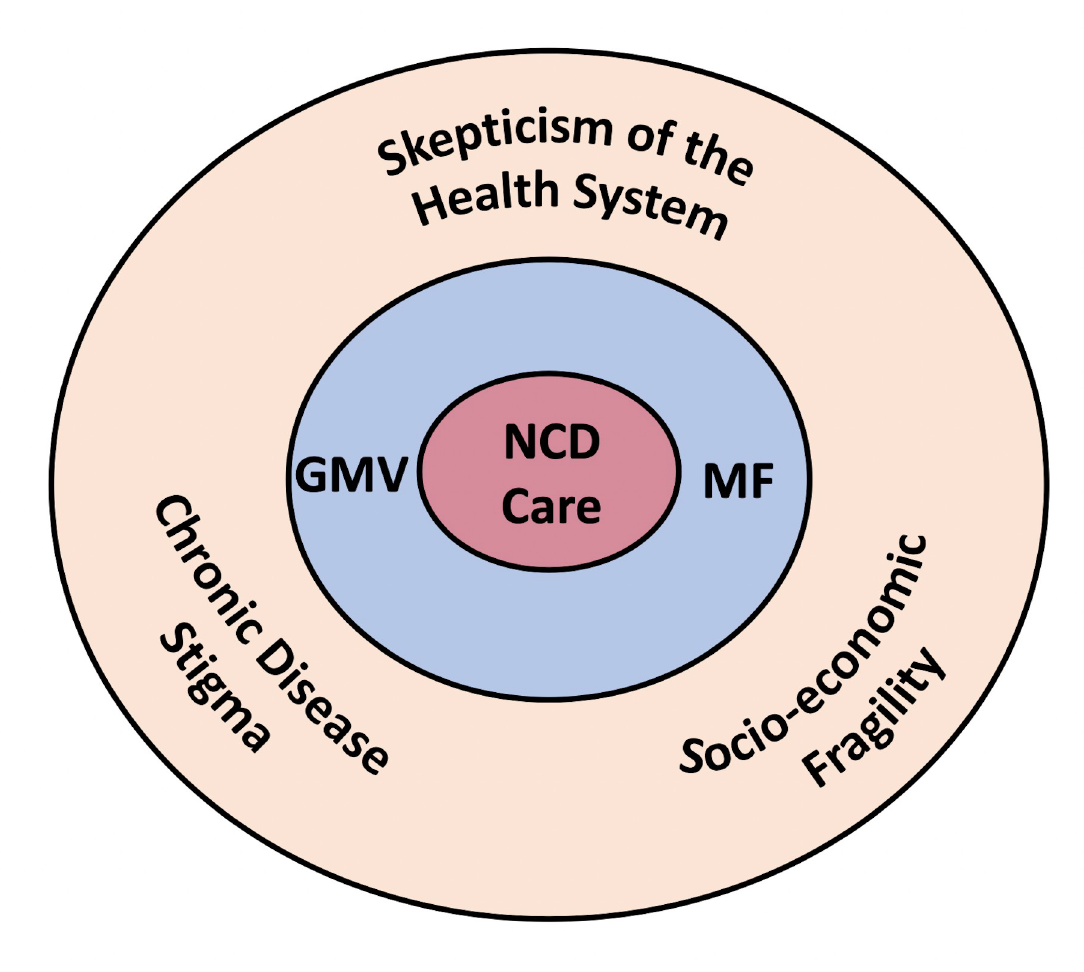
Fig 2. Conceptual representation of challenges to NCD care that can be mitigated by GMV and MF. Conceptual model.